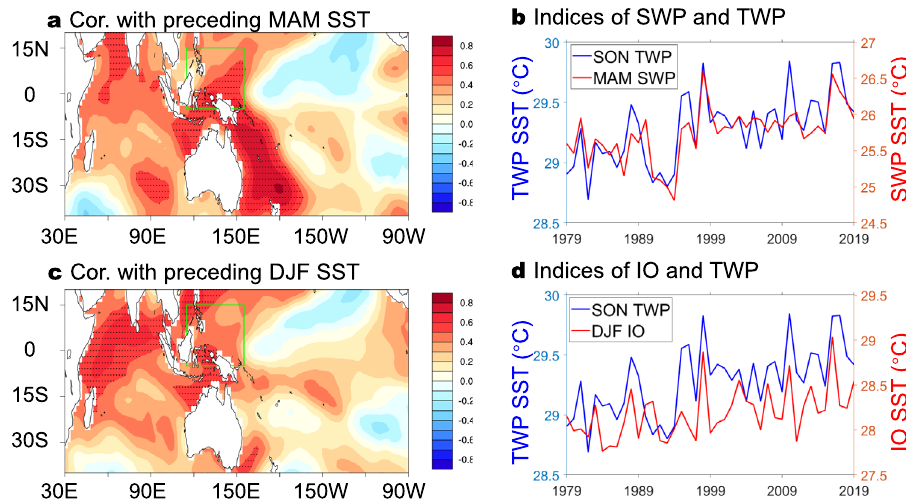
Fig. 1 Lead-lag relationship between the TWP and SWP. The correlations of the SON TWP (green box in the fi gure, 5°S – 15°N, 115°E – 155°E) SST index with the preceding ( a ) MAM and ( c ) DJF SST. b and d are the corresponding time series of Southwest Paci fi c SST index and Indian Ocean SST index for the period 1979 – 2019. They are de fi ned as the weighted average of SSTs in the regions of (35°S – 15°S, 150°E – 170°E) and (5°S – 10°N, 50°E – 90°E), respectively. The dotted shading indicates the correlation is signi fi cant at the 95% con fi dence